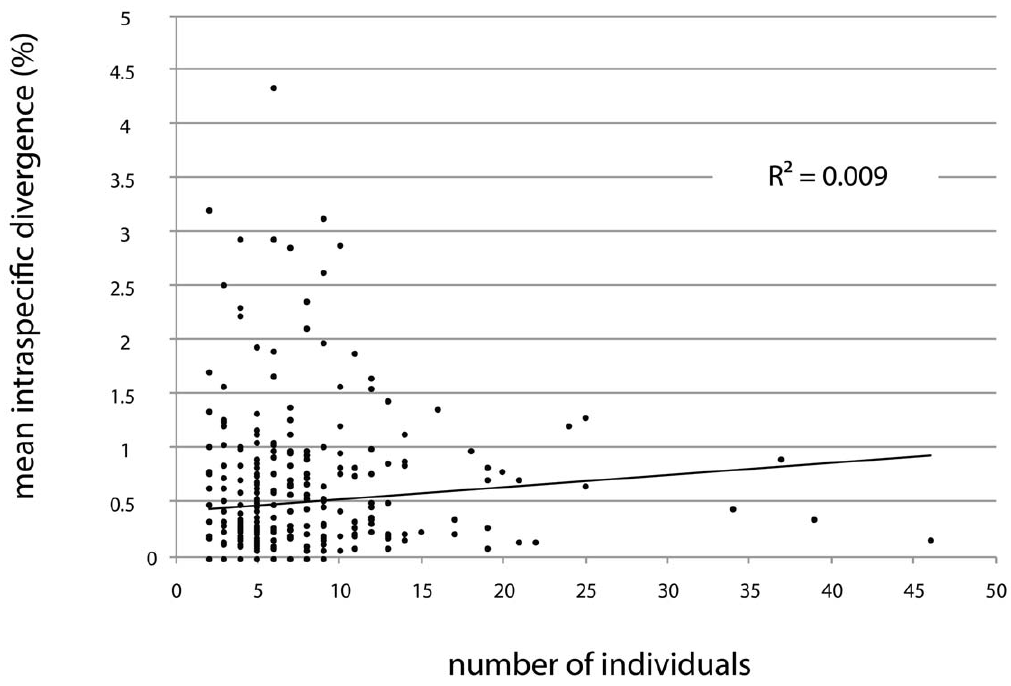
Figure 2. The relationship between mean intra-specific divergence and the number of individuals analyzed. The linear regression is not significant (P=0.07).